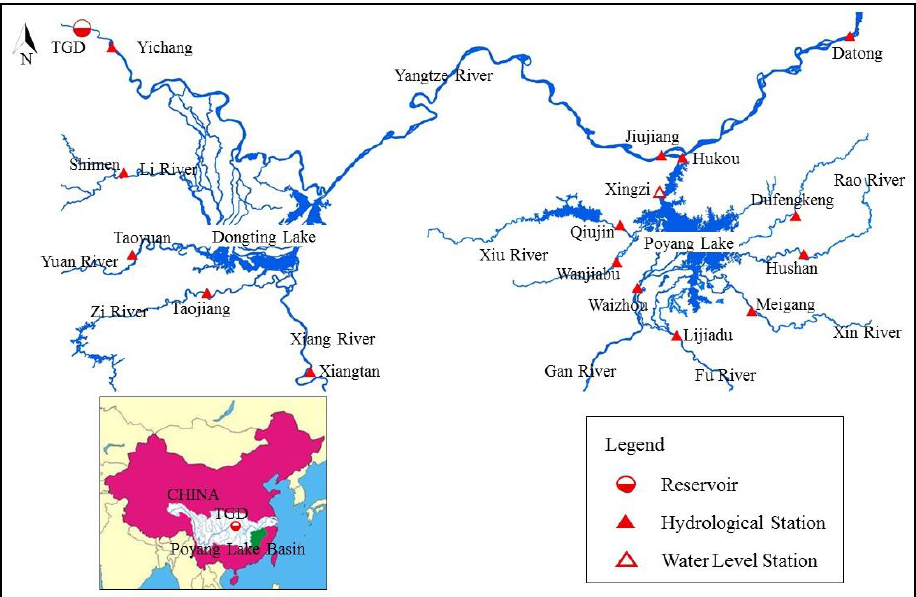
Figure 1. Locations of Poyang Lake and sketch map of hydrodynamic model domain. TGD: Three Gorges Dam.